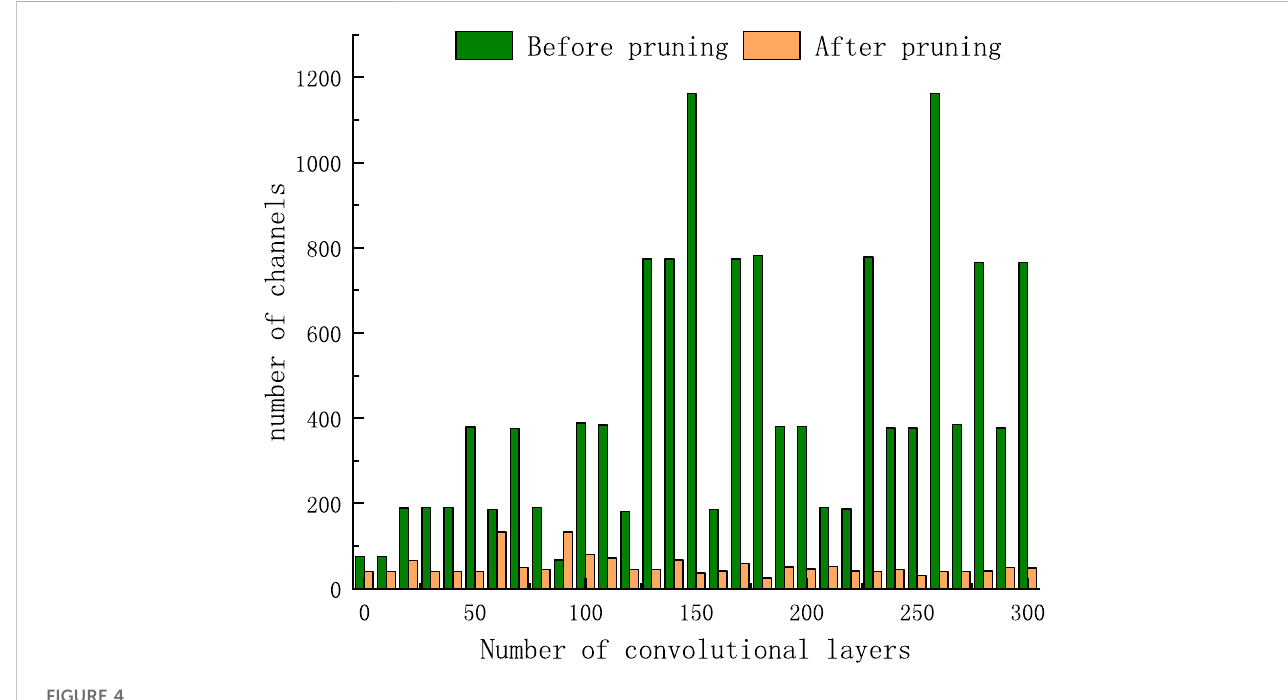
FIGURE 4 Channel changes before and after pruning.